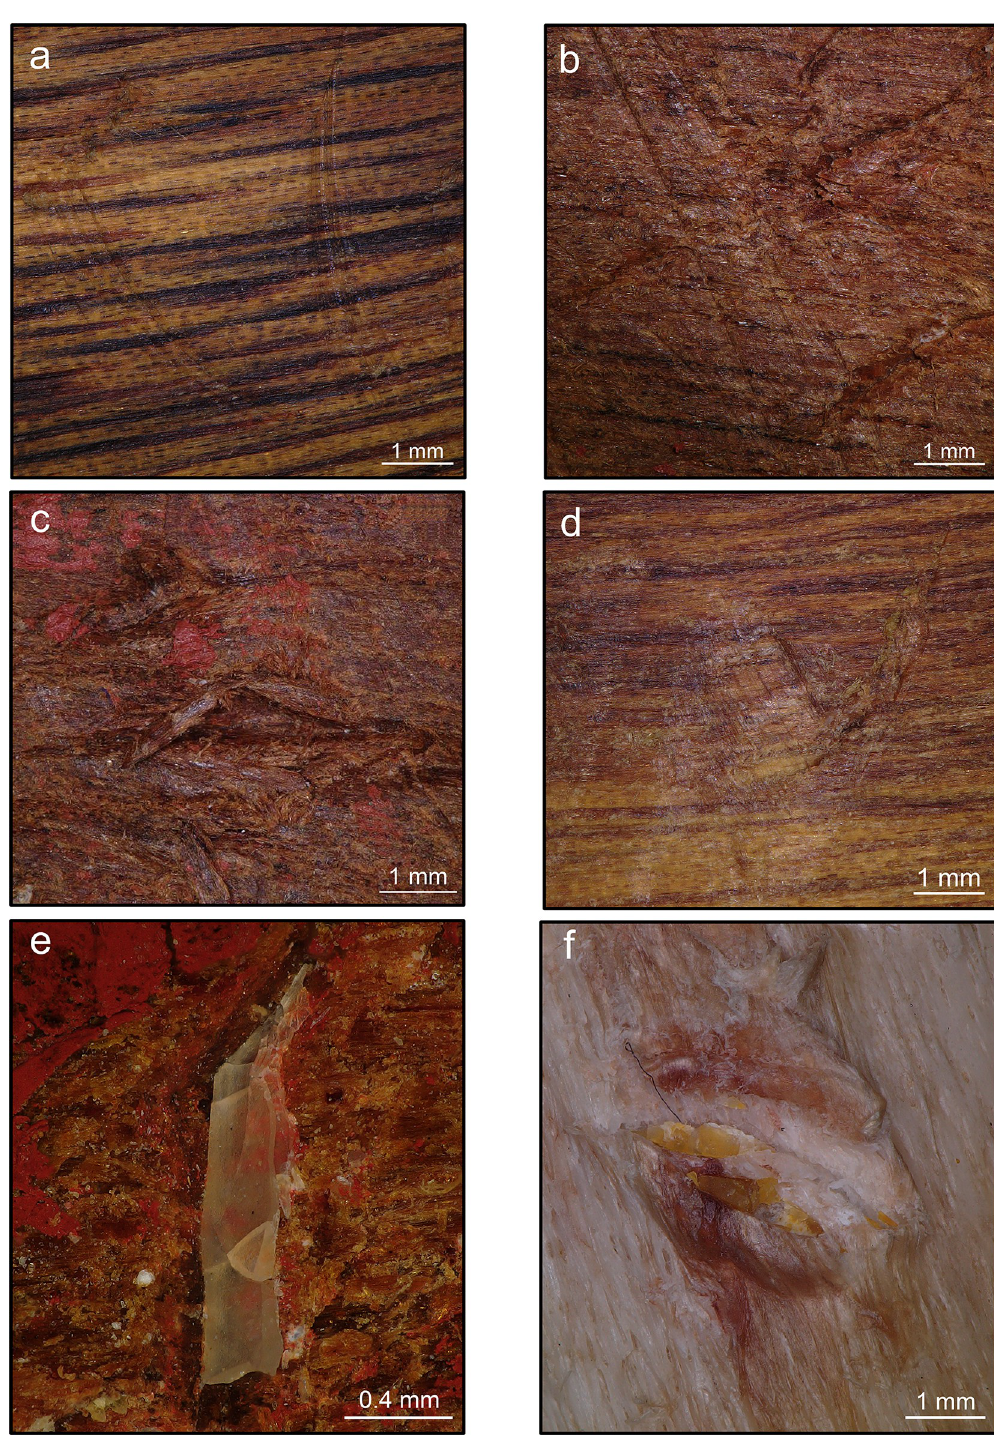
Fig 9. Images of other marks identified within the use areas on boomerangs. (a) striations associated with punctiform and linear impressions (3x); (b) scraping marks interacting and intersecting with linear and punctiform impressions (3x); (c) peeling-like use-wear (3x); (d) tool-edge scratches interacting and intersecting with linear impressions (3x); (e) flint chip embedded in linear mark on boomerang surface (10x); (f) flint chip embedded in linear marks on bone retoucher surface (R6_2)